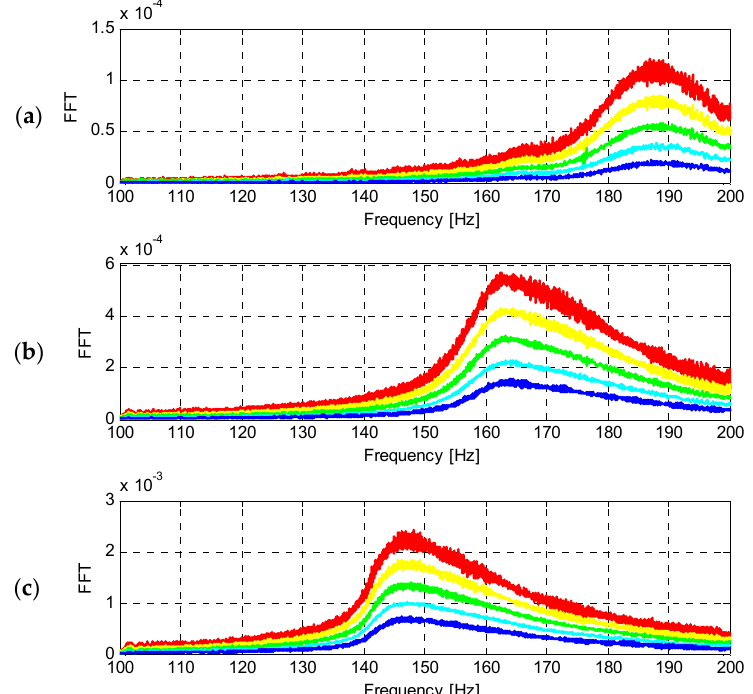
Figure 32. Power spectral density of the results from the additional accelerometers. Material: saclSi 1; Isotropic pressure 100 kPa; Frequency spectrum 100–250 Hz; Excitation (torque) amplitude: ( a ) 0.5 V, ( b ) 2 V, ( c ) 4 V (– the top sensor, S1, – the second sensor from the top, S2, – the third sensor from the top, S3, – the fourth sensor from the top, S4, – the bottom sensor,